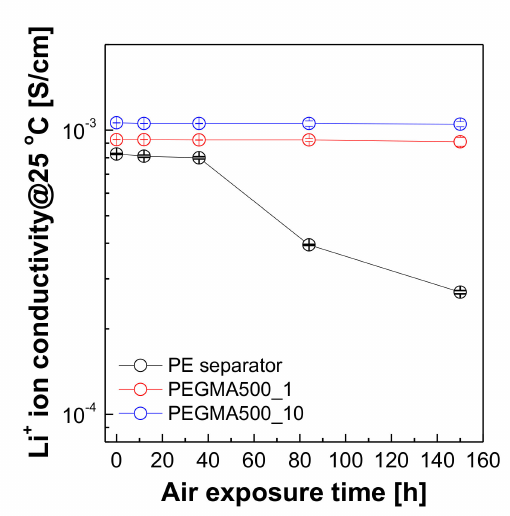
Figure 8. Lithium ion conductivity changes according to the different storage time.